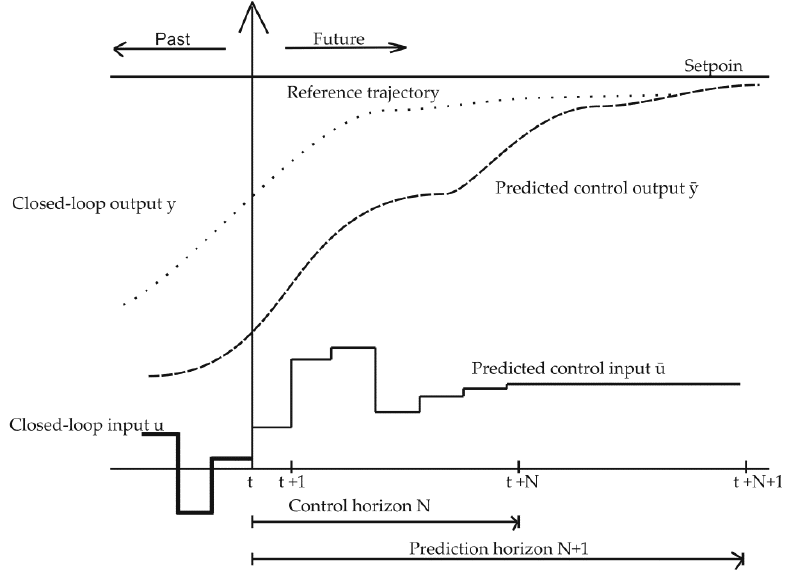
Figure A2. Principle of a MPC [100].